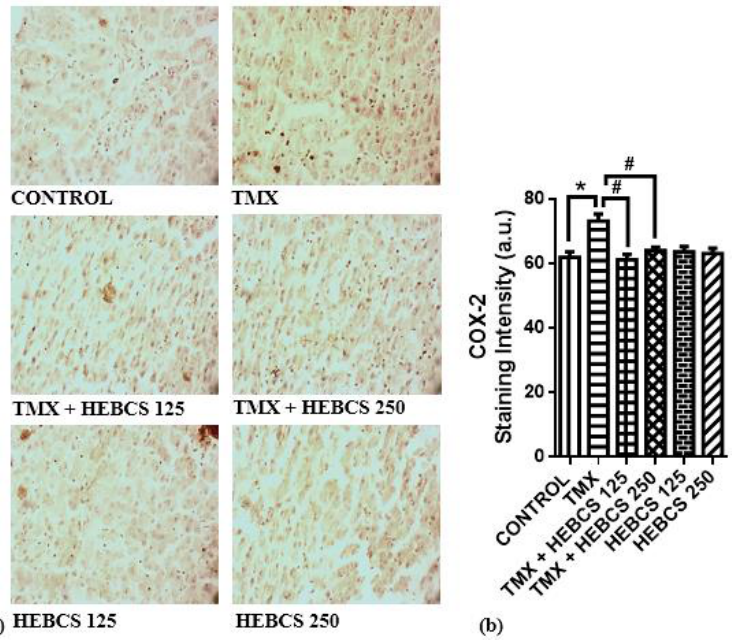
Figure 9. Immunohistochemistry slides (×200) ( a ) showing the hepatic expression of COX-2 in rats. Bar chart in ( b ) shows the staining intensity of each slides. Staining intensity of positive areas was measured using ImageJ. Data are presented as mean ± SD ( n = 6). * p < 0.05 Control versus other groups; # p < 0.05 TMX versus HEBCS groups. COX-2: cyclooxygenase 2; TMX: Tamoxifen; HEBCS 125 and 250: Hydroethanolic Extract of Buchholzia coriacea Seeds, 125 and 250 mg/kg body